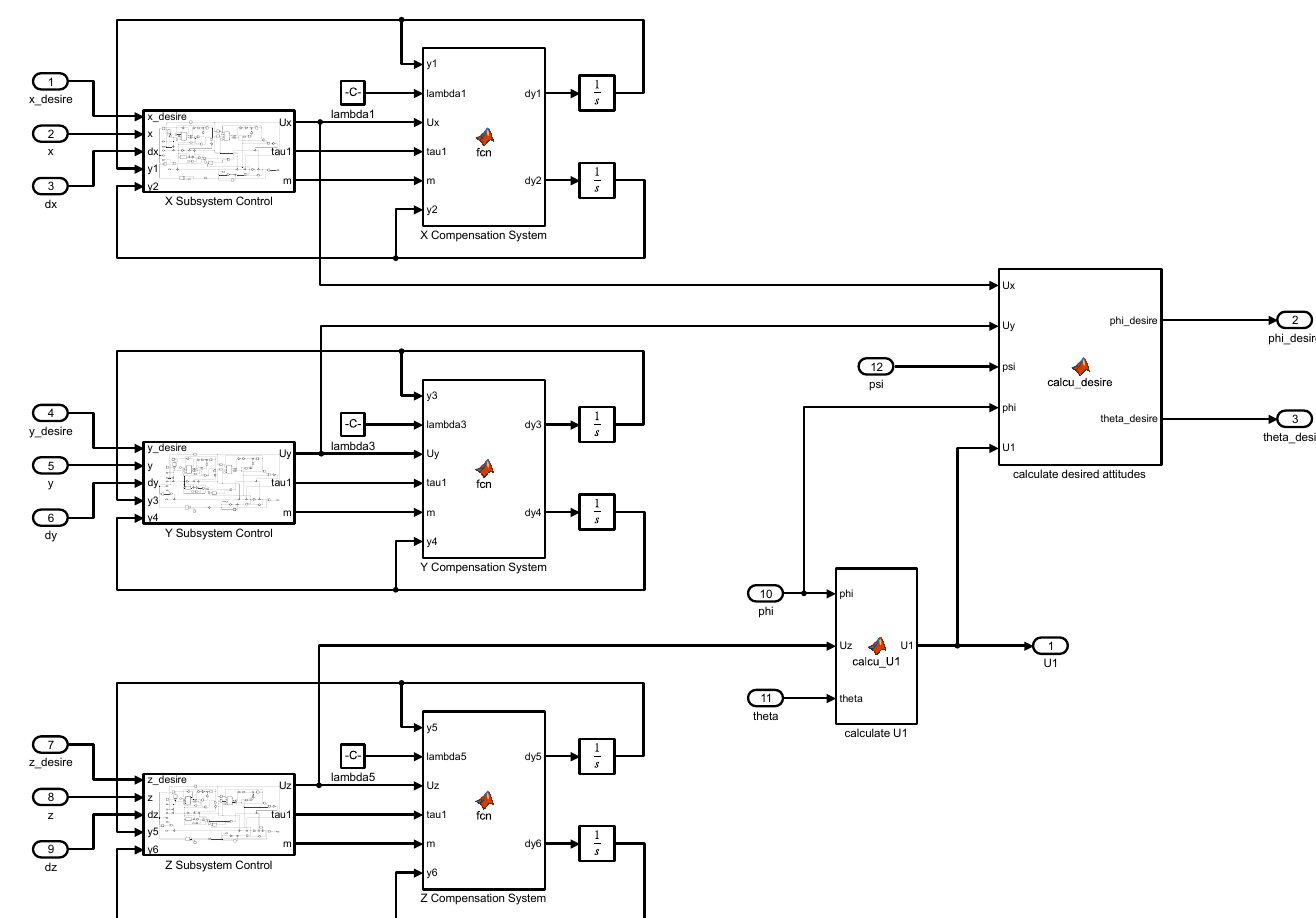
Figure A2. Simulink diagram of the position controller.